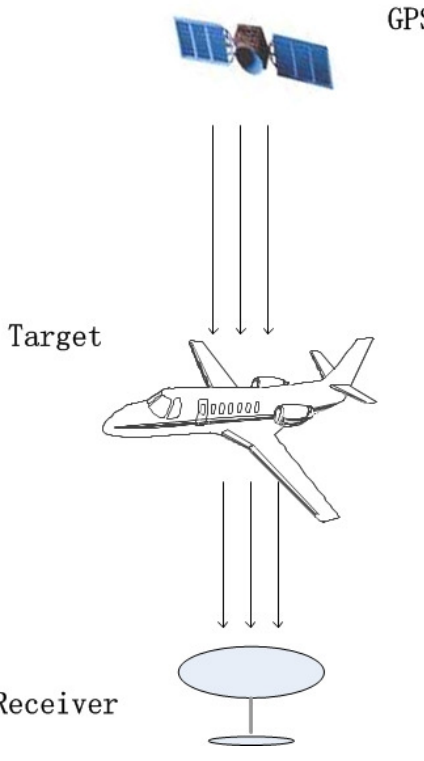
Figure 1. GPS waveforms-based forward scatter system